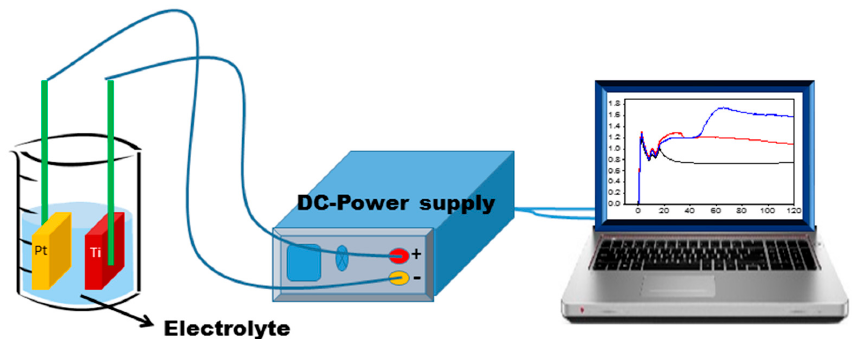
Figure 9. Schematic illustration of anodic oxidation setup.